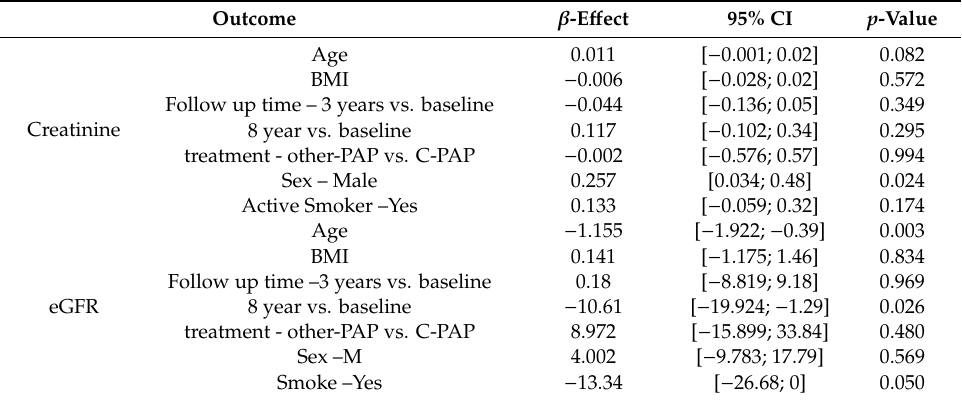
Table 4. Estimates, 95% confidence interval, and a p -value for the multiple GEE model. Outcome β -E ff ect 95%